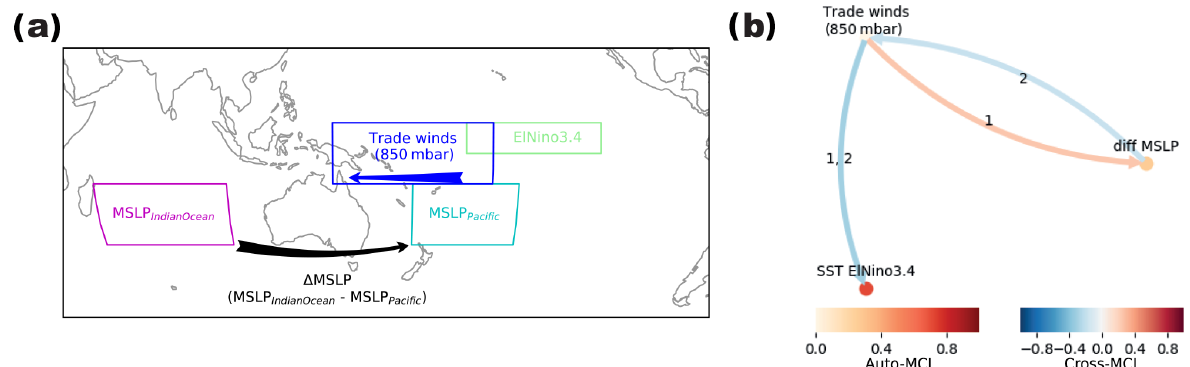
Figure 10. Causal effect network (CEN) to test if the detected robust precursor in March affects ENSO variability. (a) Regions included to construct the time series that enter the CEN. To describe the robust precursors, we include the MSLP difference between the southern Indian Ocean (magenta box) and the western South Pacific (cyan box). We further include an index of western Pacific trade winds at 850hPa (blue box) and SSTs in the Nino3.4 region (green box). (b) Resulting CEN of the time series calculated over the regions as shown in panel (a) . For the CEN calculation only the months February to July and time lags of 1 to 4 months are considered. The colour of the arrows indicates the link strengths, with the colour of the nodes indicating the strength of the